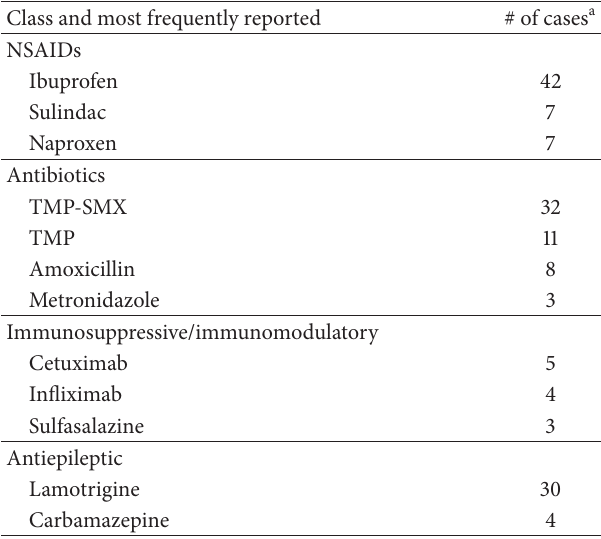
Table 1: Drug induced aseptic